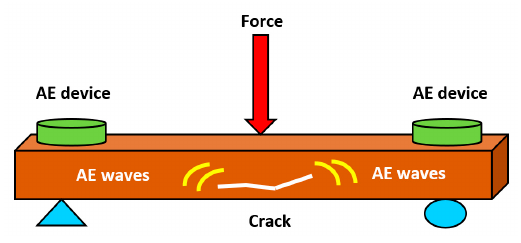
Figure 1. Acoustic emission (AE) technique.